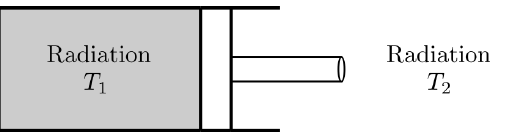
Figure 1. Encapsulated radiation in a frictionless